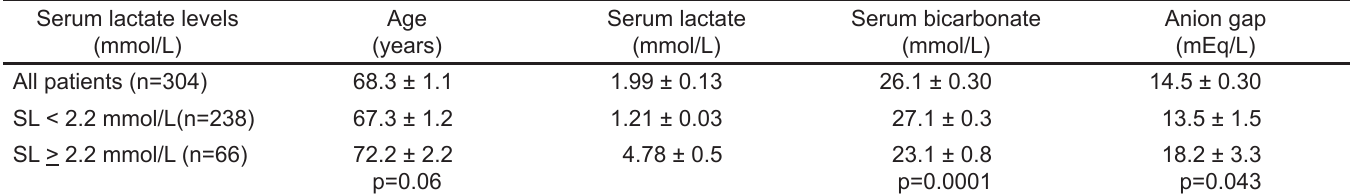
Table 1. Patient demographics and serum electrolyte